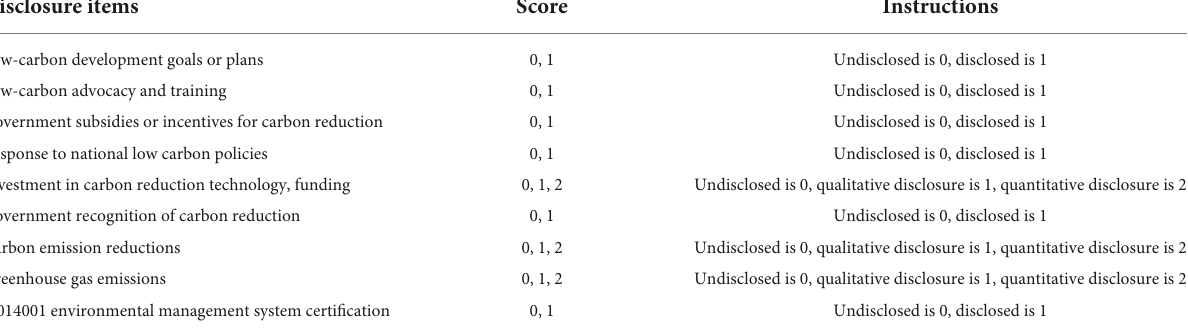
TABLE 1 Specifications of carbon information